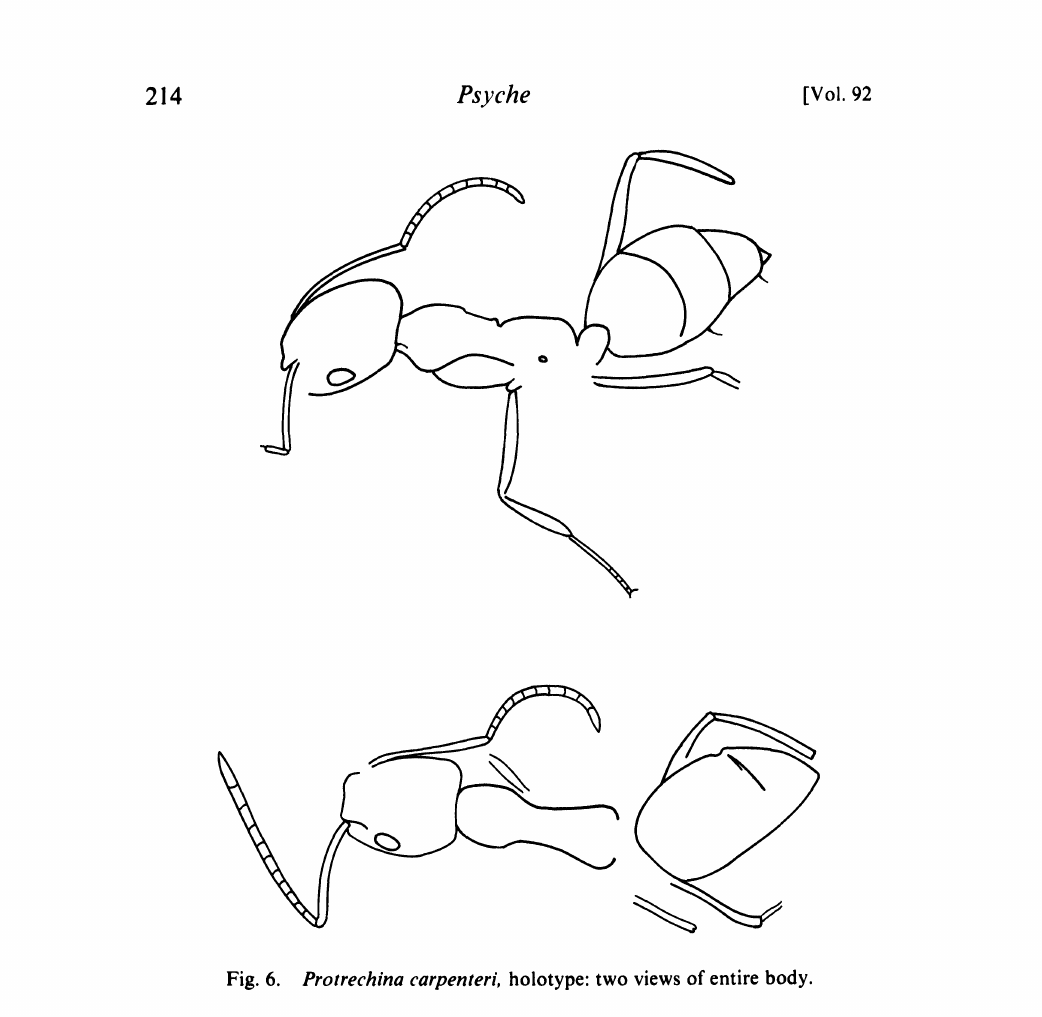
Fig. 6. Protrechina carpenterL holotype: two views of entire